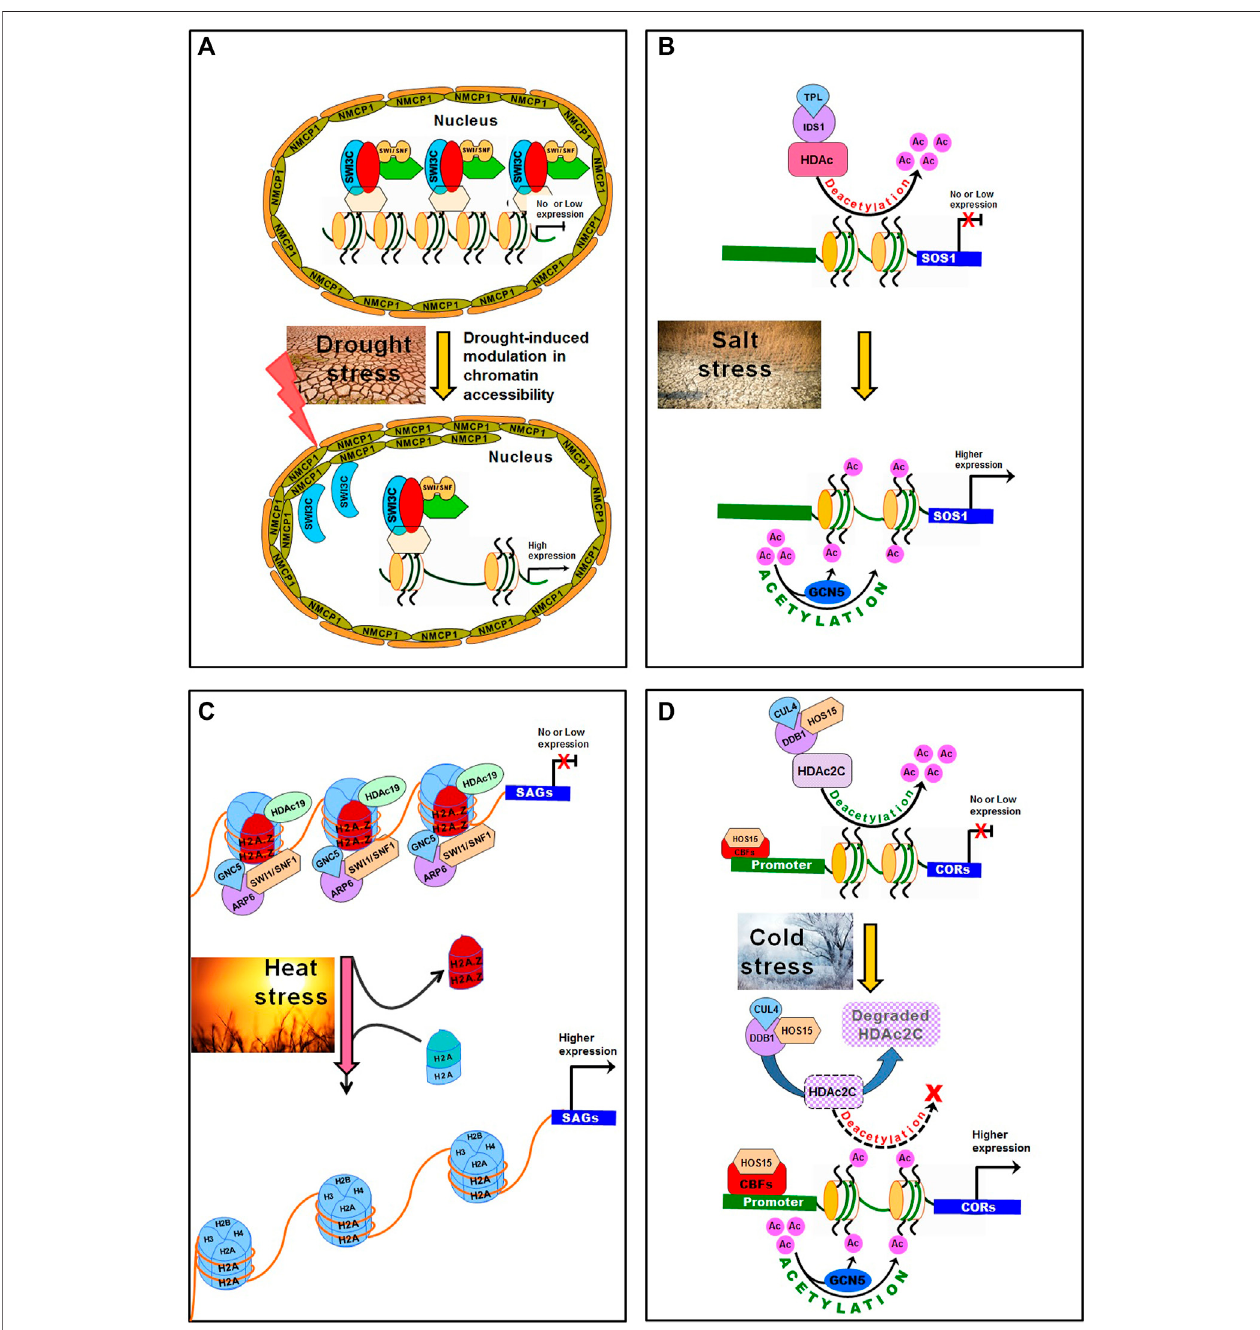
FIGURE 4 | Modulation in chromatin accessibility under abiotic stresses in plants. (A) Normally, the lamin-like proteins OsNMCP1 regulate drought tolerance throughmodulatingchromatinaccessibility via interactionwithachromatin remodeler OsSWI3C inrice.Switch/SucroseNon-Fermenting(SWI/SNF) complexes interact with OsSWI3C to change the structure of nucleosome, resulting in gene silencing. Under drought stress, OsNMCP1 gets induced and interacts with OsSWI3C, which releasesOsSWI3Cfromthegene-silencingSWI/SNFcomplexes,resultinginimprovedchromatinaccessibilityandhigherexpressionofdrought-responsivegenes. (B) Topless-like/Topless-likeprotein(TPL/TPR) and Indeterminate Spikelet1(IDS1)interactwithHistone Deacetylase(HDAc) toformanIDS1-TPL-HDA1 transcriptional repression complex through histone deacetylation. Under salt stress, acetylation of H3K9 and H3K14 by histone acetyltransferase (General Control Non-repressed Protein 5, GCN5), contributes to salt tolerance by activating salt stress-responsive genes (e.g. SOS1). (C) Under heat stress, SWI1/SNF1 complex interacts with GCN5 and ARP6 to dissociate H2A.Z (and insertion of H2A into the nucleosome), which causes no transcription of heat-responsive genes. On normal weather, the SWI1/ SNF1 — ARP6 complex plays important role in placing H2A.Z into the nucleosome. (D) Under cold stress, HOS15, in association with DNA Damaged Binding Protein1 (DDB1)andCullin4(CUL4)actsasE3ubiquitinligasewhichdegradesHDAc2CcausinghyperacetylationofhistoneH3onColdRegulated(COR)chromatin.Thismakes bindingofCBF proteins toCORpromoterthroughHigh-expressionofOsmotically Responsive Gene15(HOS15) leadingtoactive expression ofCOR genes.Moreover, the GCN5 modulates histone acetylation of COR chromatin. At the normal temperature, HOS15 forms a complex with HDAc2C to repress COR expression via hypoacetylation of the COR chromatin.